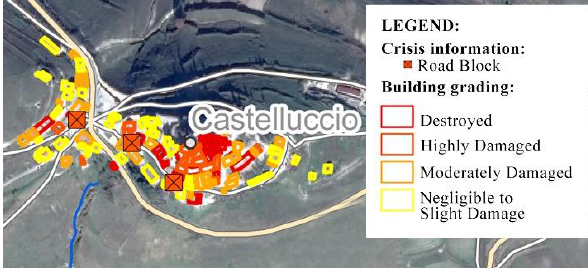
Figure 10. Copernicus EMS (© 2016 European